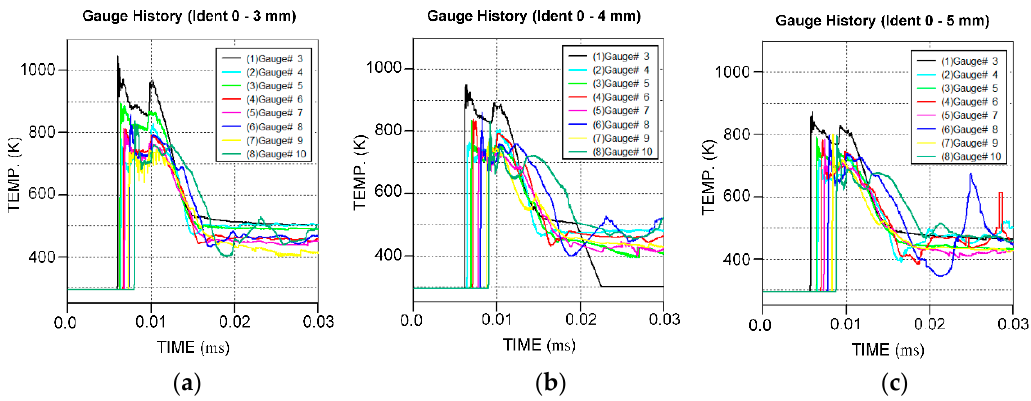
Figure 12. Temperature–time curves of gauges for different reactive liner thicknesses. ( a ) b 1 = 3 mm;